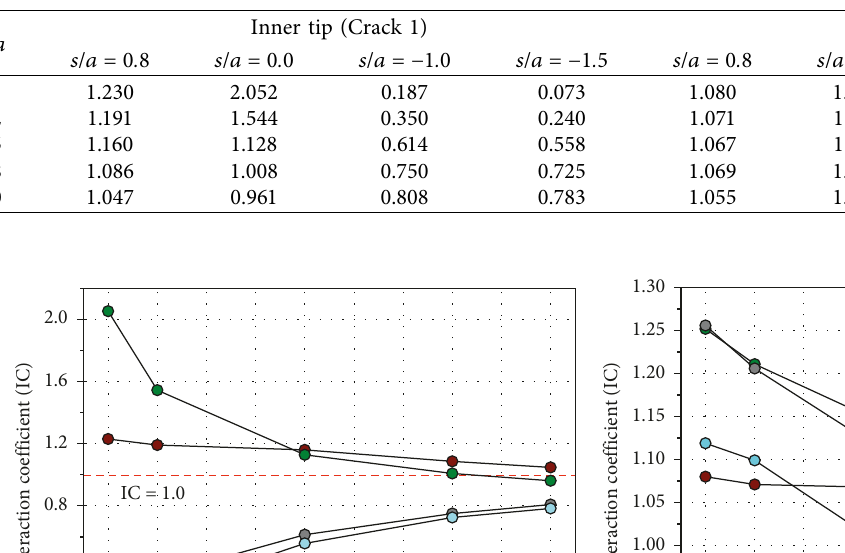
Table 1: ICs varying with staggered distance ratio ( h / a ).